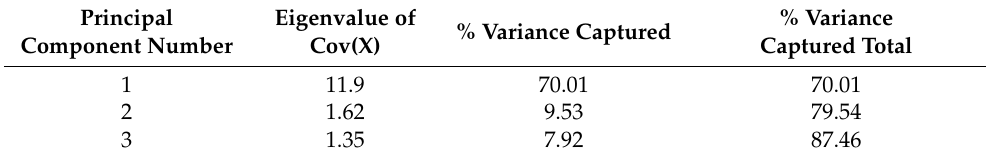
Table 3. The number of principal components and the percentage of variance they